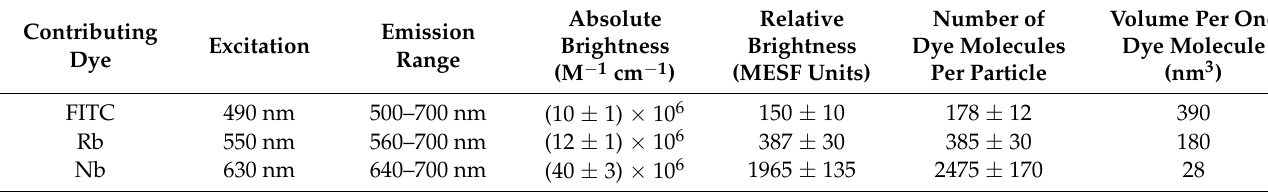
Table 1. Fluorescence properties of ultrabright pH and temperature-sensing nanoparticles. Relative fluorescence brightness of ultrabright mesoporous silica nanoparticles in both MESF units (relative to one free dye molecule) and M − 1 cm − 1 , and the number of dye molecules per particle. Note that all the calculations were performed using the number weighted average particle size of 51